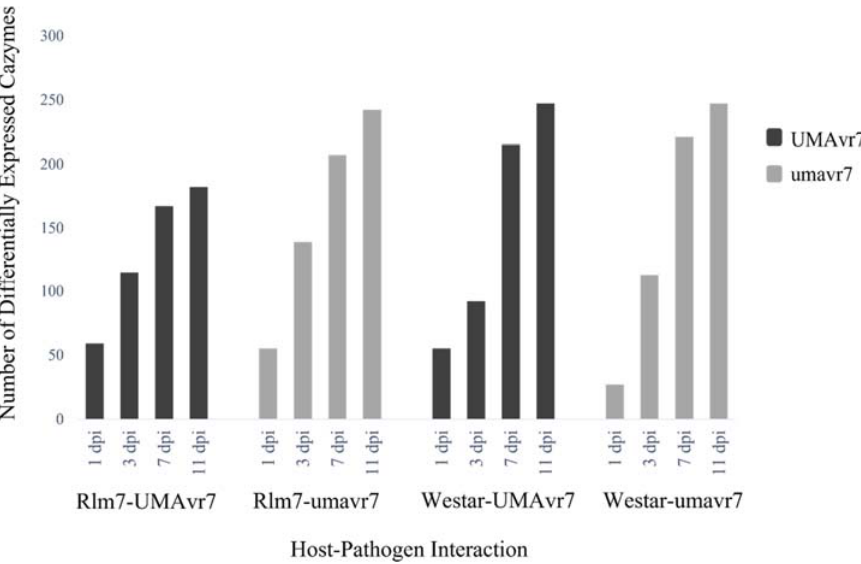
Figure 8. Differentially expressed CAZymes of Leptosphaeria maculans UMAvr7 and umavr7 isolates in infected host plants. Dual RNA-seq results exhibited differentially expressed CAZymes of UMAvr7 and umavr7 isolates in both infected 01-23-2-1 (Rlm7 line) and Westar plants. The differential expression of CAZymes was higher in compatible interactions than in the incompatible interaction. The expression level was increased with time from 1- to 11-dpi in each interaction. Results are representative of three biological replicates. The results were considered at the fold-change cutoff (logFC) of ≥ 1 and ≤− 1 and false discovery rate (FDR) of ≤ 0.05.